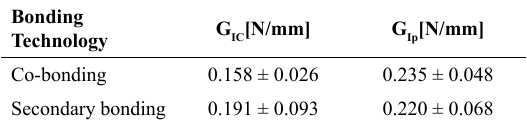
Table 1. Pure Mode I initiation (G toughness values of co bonding and secondary bonding